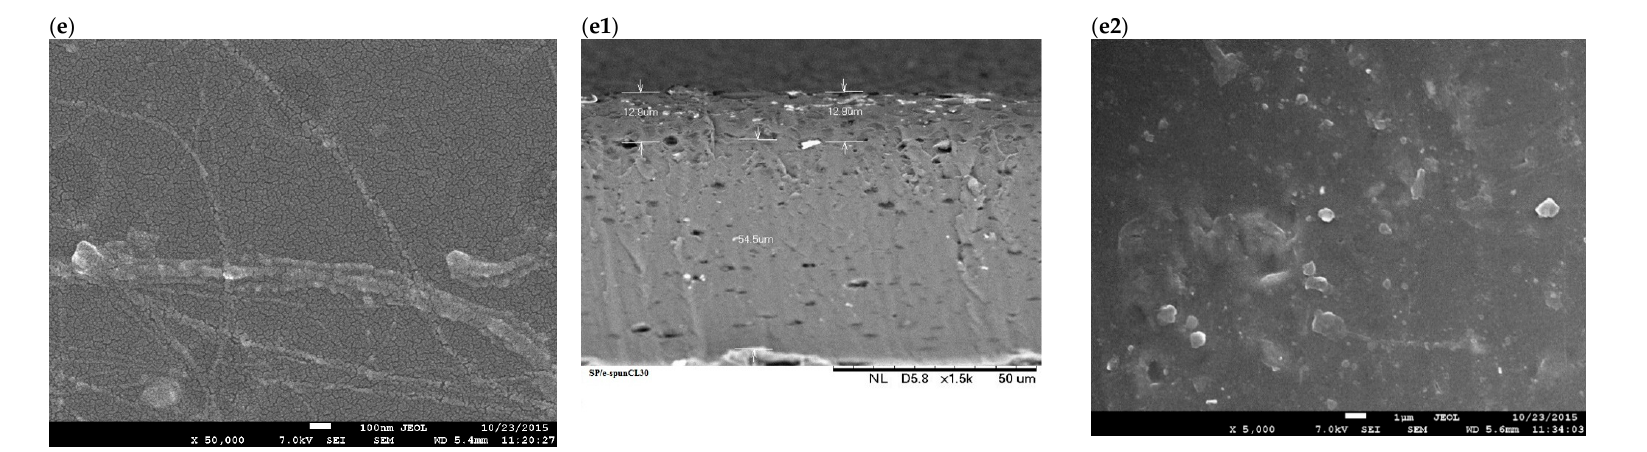
Figure 6. ( a – e2 ): ( a – e ) FESEM surface images of all membranes ( a ) SP/e-spunCL10, ( b ) SP/e-spunCL15, ( c ) SP/e-spunCL20, ( d ) SP/e-spunCL25, ( e ) SP/e-spunCL30), ( a1 – e1 ) SEM images of SP/e-spunCL cross sectional areas ( a1 ) SP/e-spunCL10, ( b1 ) SP/e-spunCL15, ( c1 ) SP/e-spunCL20, ( d1 ) SP/e-spunCL25, ( e1 )